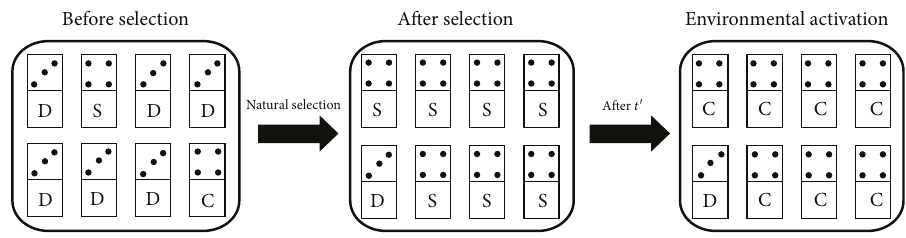
Figure 3: Silent genes and genetic hitchhiking: a cooperative gene in a world of defectors will be heavily exploited with no other cooperators to interact with. Hence, it has low chances of spreading in the population. A silent gene, on the other hand, does not a ff ect its carriers ’ fi tness till activation. And, it might hitchhike a selective sweep if it happened to be in an organism with relatively higher fi tness, due to in fl uence of the rest of the genes.